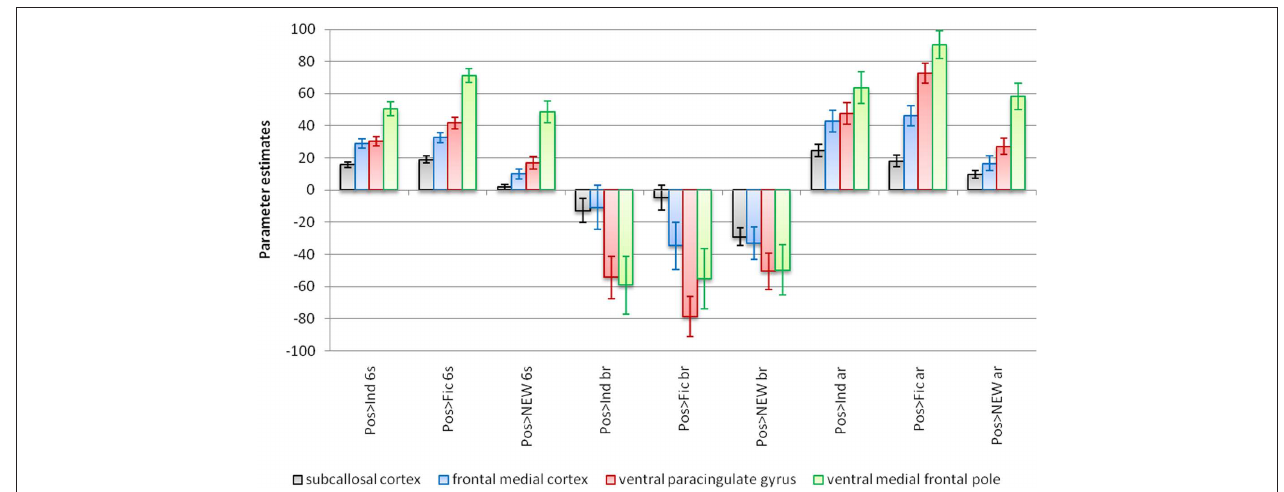
FIguRe 7 | Parameter estimates for the stimuli in four local maxima in the vmPFC (subcallosal cortex: − 6, 32, − 10; frontal medial cortex: 2, 36, − 14; ventral paracingulate gyrus: − 2, 48, − 2; ventral medial frontal pole: − 2, 58, 4). The bar graphs identified with the suffix 6 s are the conventional GLM-based analysis of fMRI data. The bar graphs identified with the suffix br refer to the